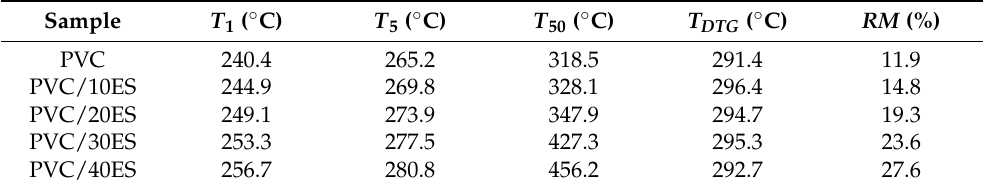
Figure 5. TG thermograms of PVC and PVC/ES composites in nitrogen. Table 3. Results of TG analysis.